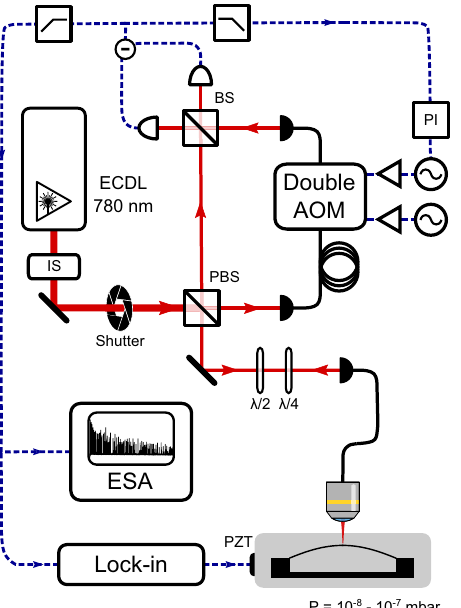
Fig. 8 Simpli fi ed scheme of the mechanical characterization setup. ECDL external cavity diode laser, IS intensity stabilizer, PBS polarizing beam splitter, BS 50 – 50 beam splitter, AOM acousto-optic modulator, λ /2 and λ /4 half-wave and quarter-wave plate, PI proportional-integral feedback controller, PZT piezoelectric actuator, ESA electrical spectrum